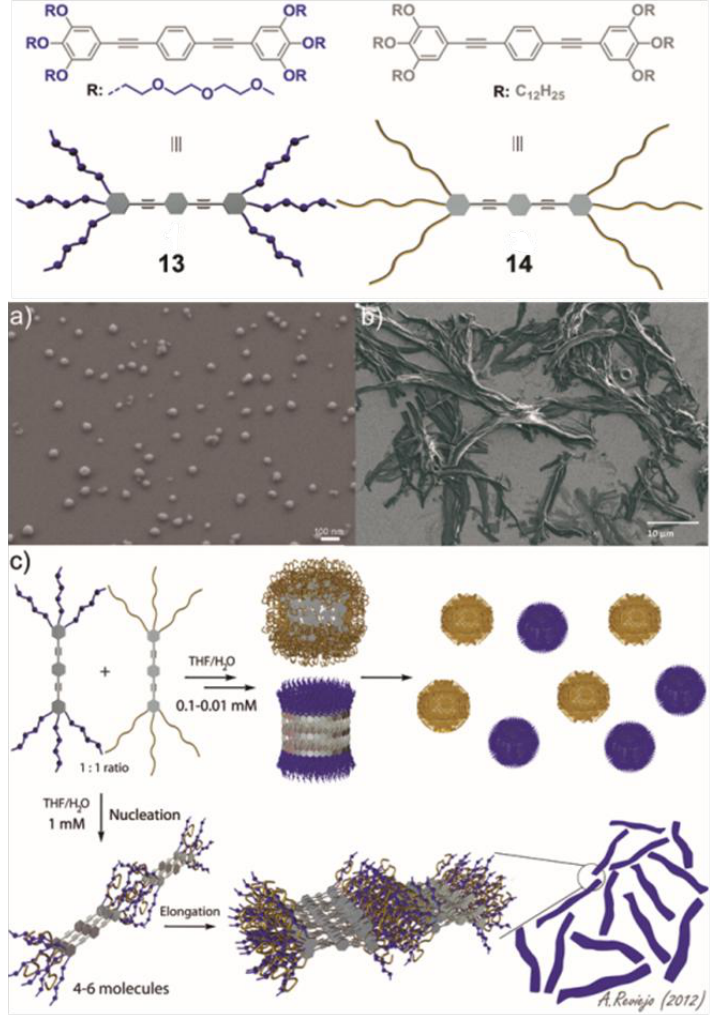
Figure 6. Chemical structures and cartoon representation of OPEs 13 and 14 . SEM images of a 1:1 mixture of 13 and 14 in THF/water at ( a ) 0.1 mM and ( b ) 1 mM on silicon wafer; ( c ) Cartoon representation of the concentration-dependent self-sorting behavior of a 1:1 mixture of 13 and 14 in THF/water (1:1). Narcissistic self-sorting at concentrations between 0.01 and 0.1 mM (top) and social self-sorting at 1 mM (bottom). Reprinted with permission from [34]. Copyright 2012